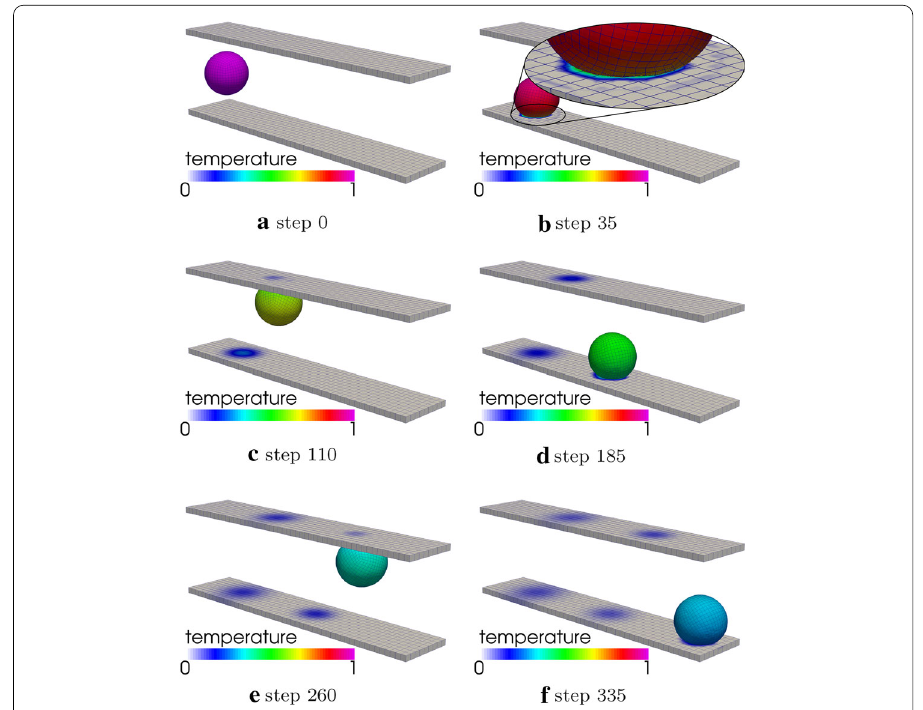
Fig. 7 Bouncing ball—temperature distribution and deformation state for ρ u, ∞ = ρ T, ∞ = 0 . 9 at different time steps